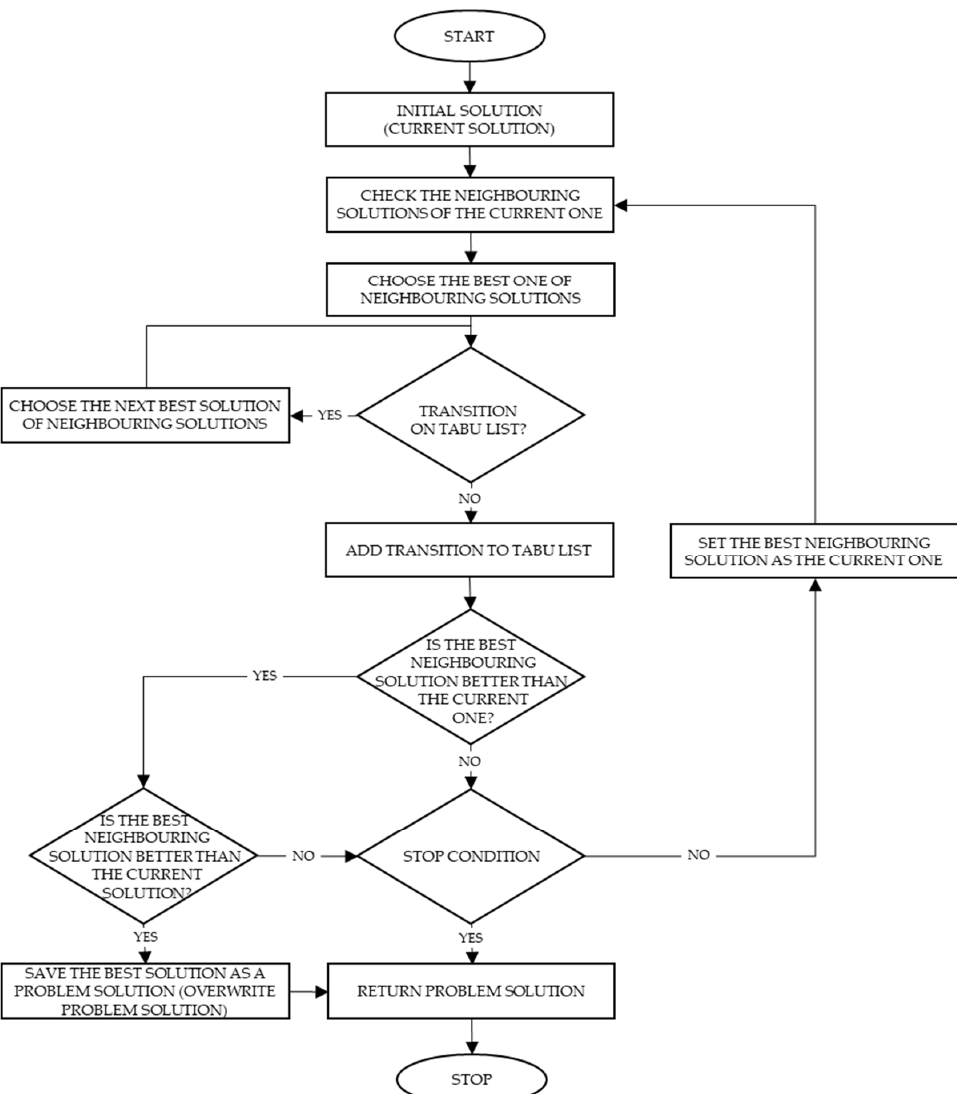
Figure 2. Tabu search diagram.